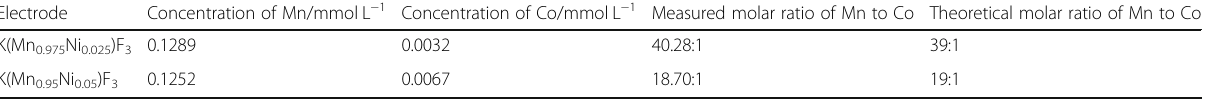
Table 1 Test results of ICP-AES of synthetic material K(Mn 0.975 Ni 0.025 )F 3 and K(Mn 0.95 Ni 0.05 )F 3 Electrode